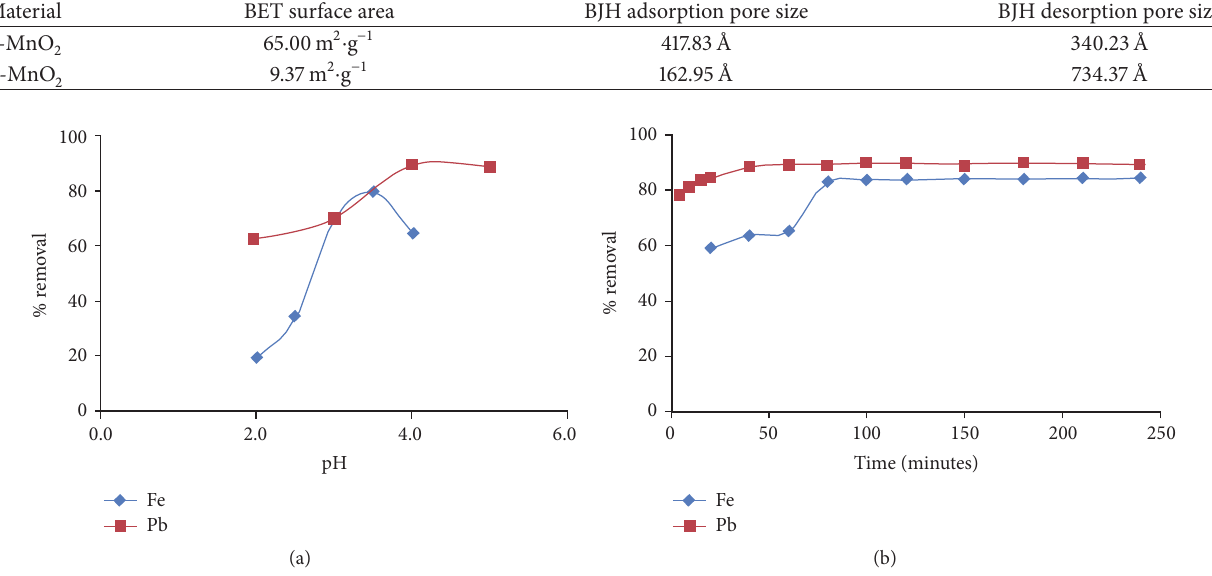
and (5 4 1), respectively (ref. code: 01-072-1982). These results corresponded with prognostication from thermal